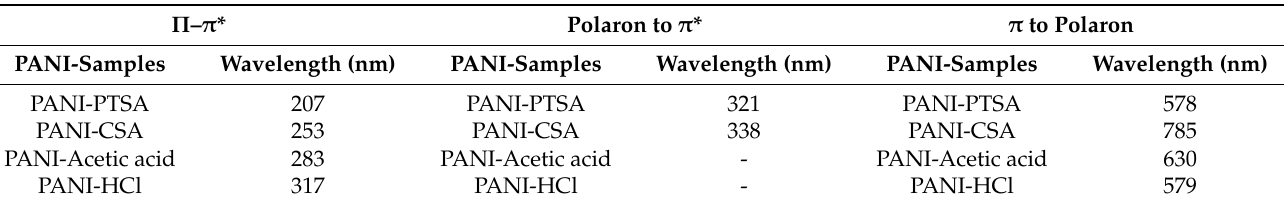
Table 6. Comparison of the absorbance values of the PANI